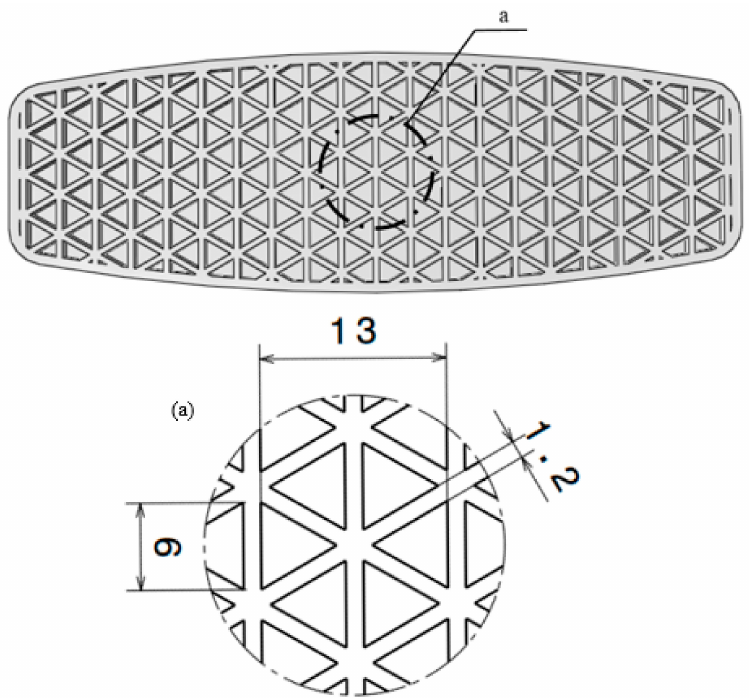
Figure 16. Bottom shell with the triangular honeycomb core structure and detailed view of section. ( a ) Geometry and dimensions of a TH unit-cell (all dimensions are in